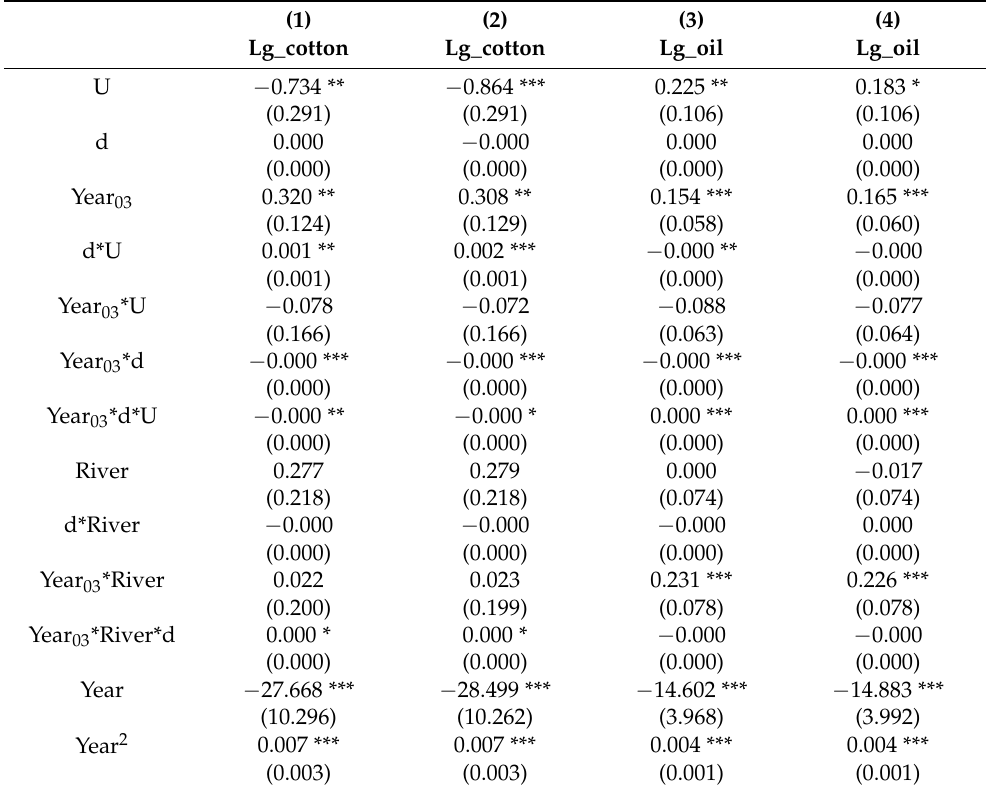
Table 10. Robust results—agricultural impact of building the TGD by setting 2003 as the basis